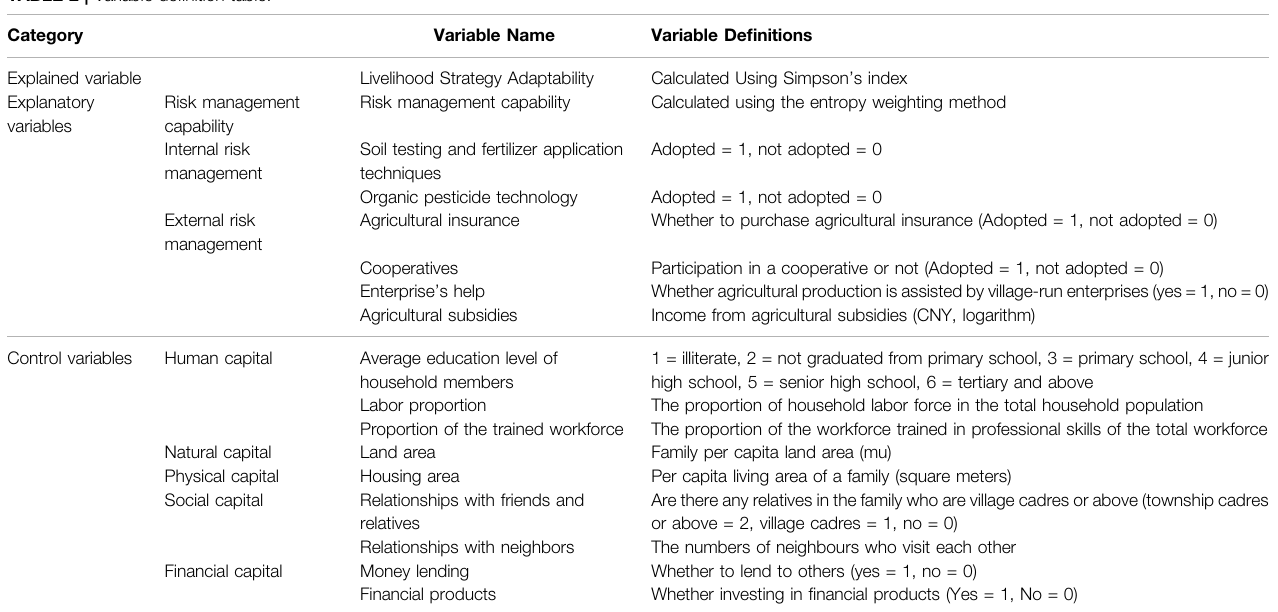
TABLE 2 | Variable de fi nition